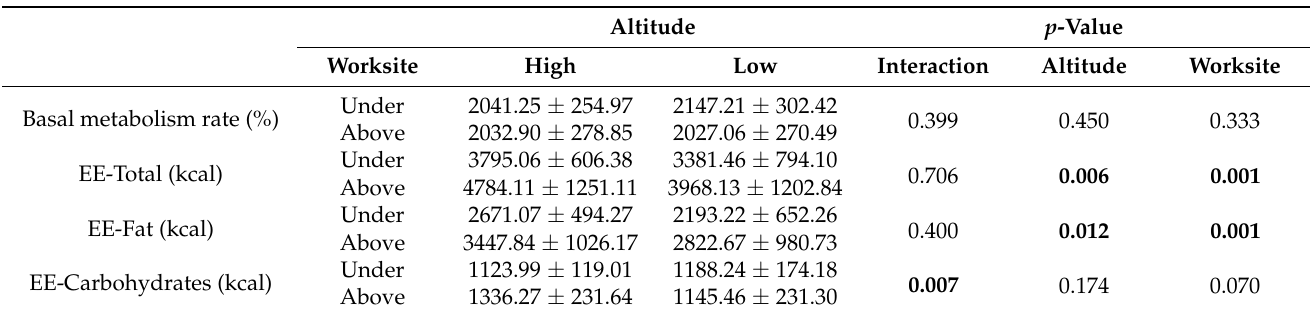
Table 3. Metabolism variables.